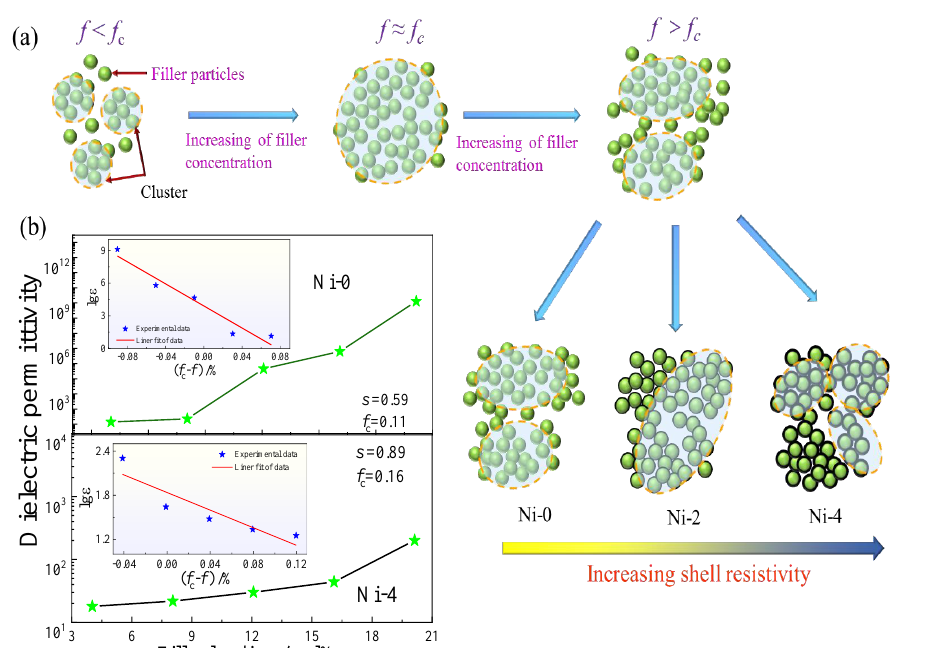
Figure 5. ( a ) Filler particles are clustered into polarizable domains (yellow blob), which describes the polarization region of polymer composites, ( b ) ε r as a function of filler concentration at 10 2 Hz for Ni – 0/PVDF and Ni – 4/PVDF composites, and the insert graph displays a log – log curves of ε r as a function of f c − f . From Figure 4b, the change in tanδ for the Ni – 0/PVDF composites exhibits no de- pendance of the filler concentration at f < f c , where the adjacent Ni particles are mainly isolated far away; however, when the filler concentration is close to the f c , the tanδ first increases by an exponential form, and then decreases sharply with frequency. For exam- ple, the PVDF with 50 wt% Ni – 0 demonstrates an enormous tanδ = 8520 at 10 3 Hz com- pared to only 0.026 for composite with 20 wt% filler. The tremendous tanδ at low fre- quency range can be interpreted by the direct current (DC) conduction from the formation of conductive network of Ni – 0 through the composites, hence, resulting in the amassed charge carriers at the different phases interface and electron conduction process. In addi- tion, the t anδ declines over the whole frequency region at the uniform filler concentration, due to the fact that the charges migration cannot keep place with the transformation of external electric field, resulting in the lack of electronic oscillations. Therefore, the enor- mous tanδ can be found in the Ni – 0/PVDF composites with intense frequency depend- ence.